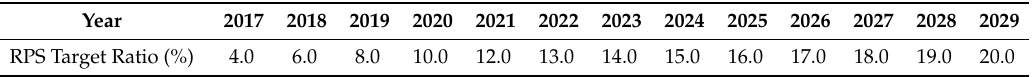
Table 5. Strengthened RPS target ratio plan.